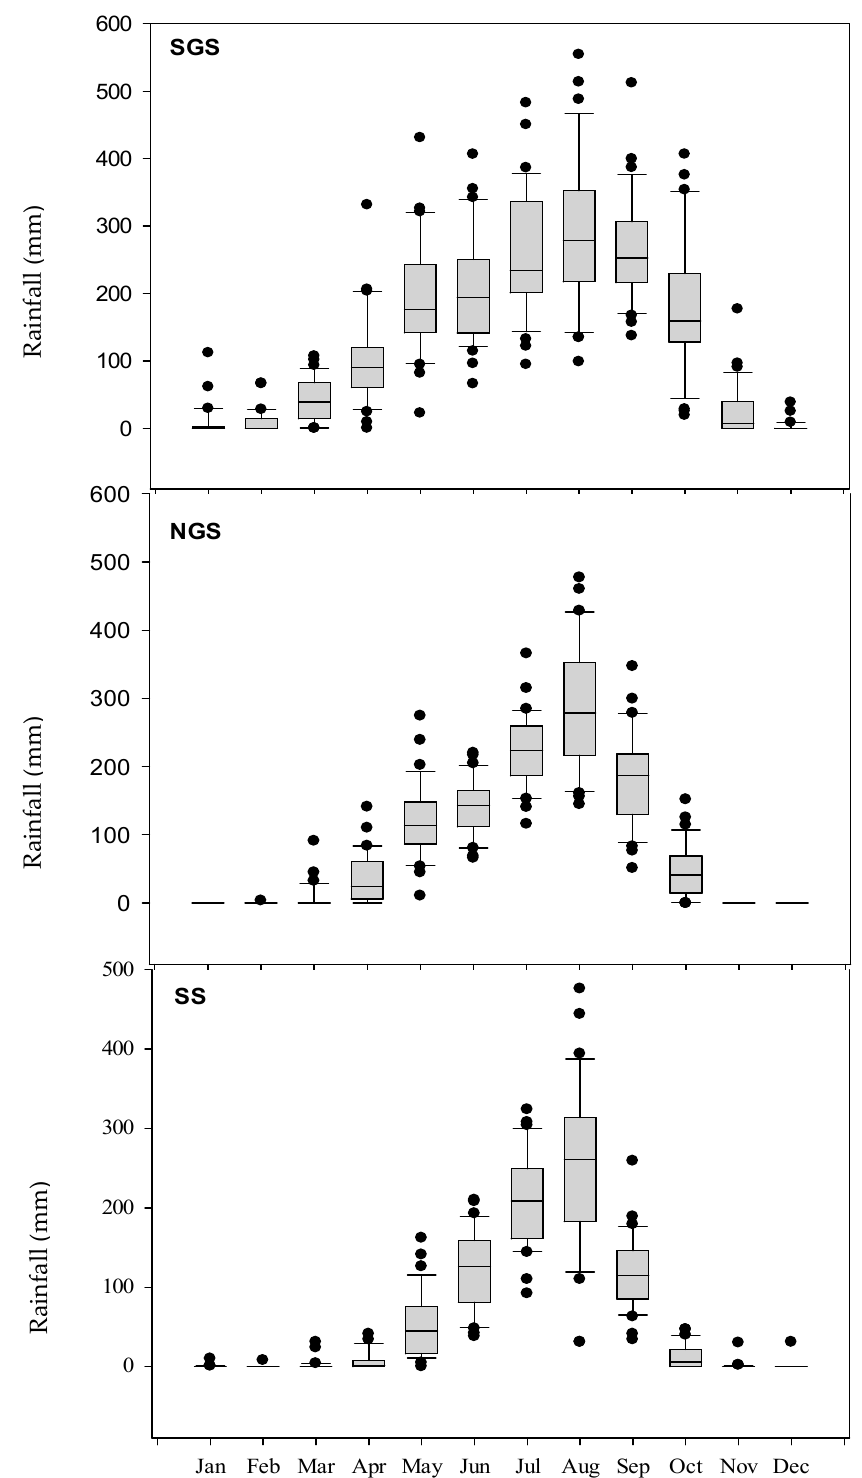
Figure 3. Thirty years monthly rainfall in SGS, NGS and SS, from 1985 to 2014. Source of data: NIMET [27].